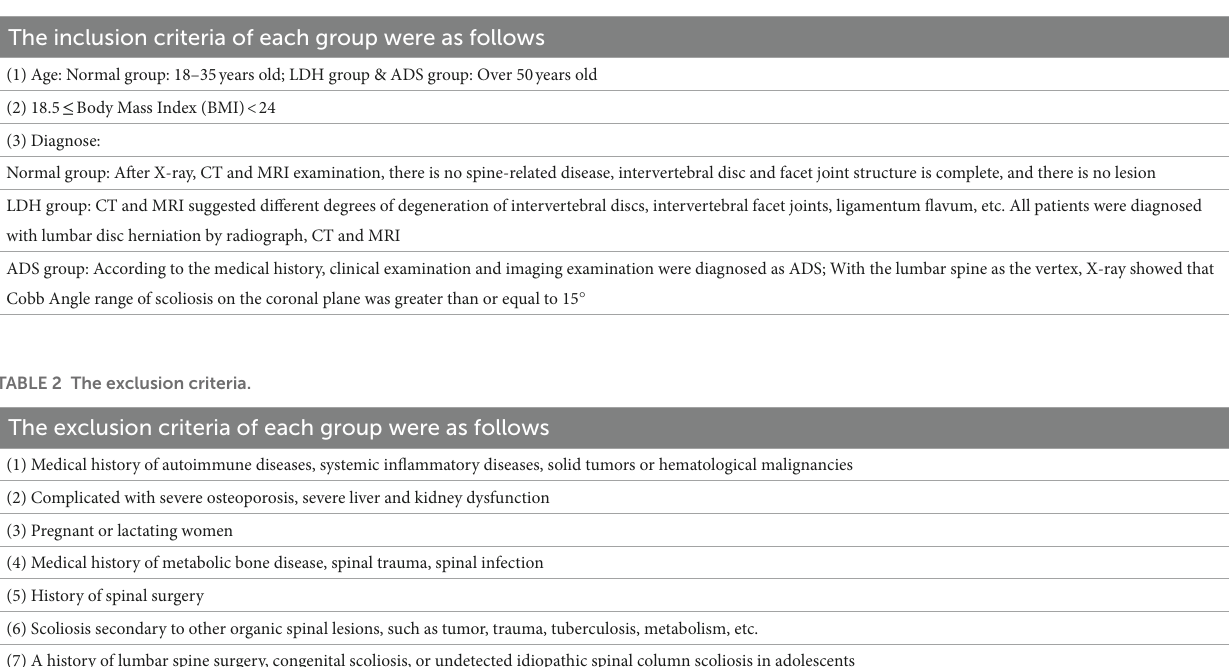
TABLE 1 The inclusion criteria.